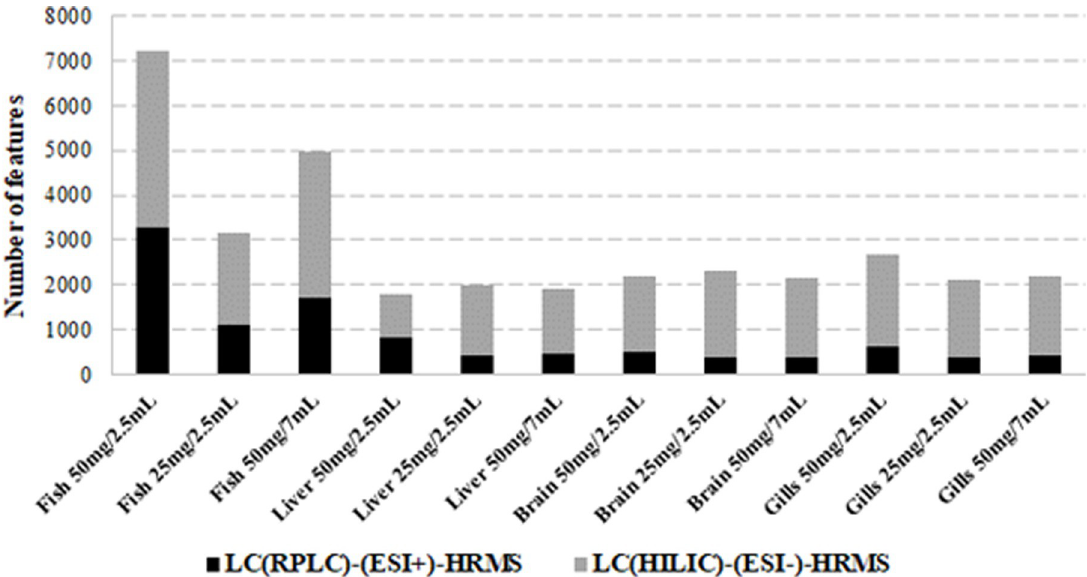
Fig 5. Number of features (m/z, R T ) detected with different sample mass and volume of the extraction solvents in fish, liver, brain or gills, analyzed in LC(RPLC)-(ESI+) and LC(HILIC)-(ESI-) HRMS.